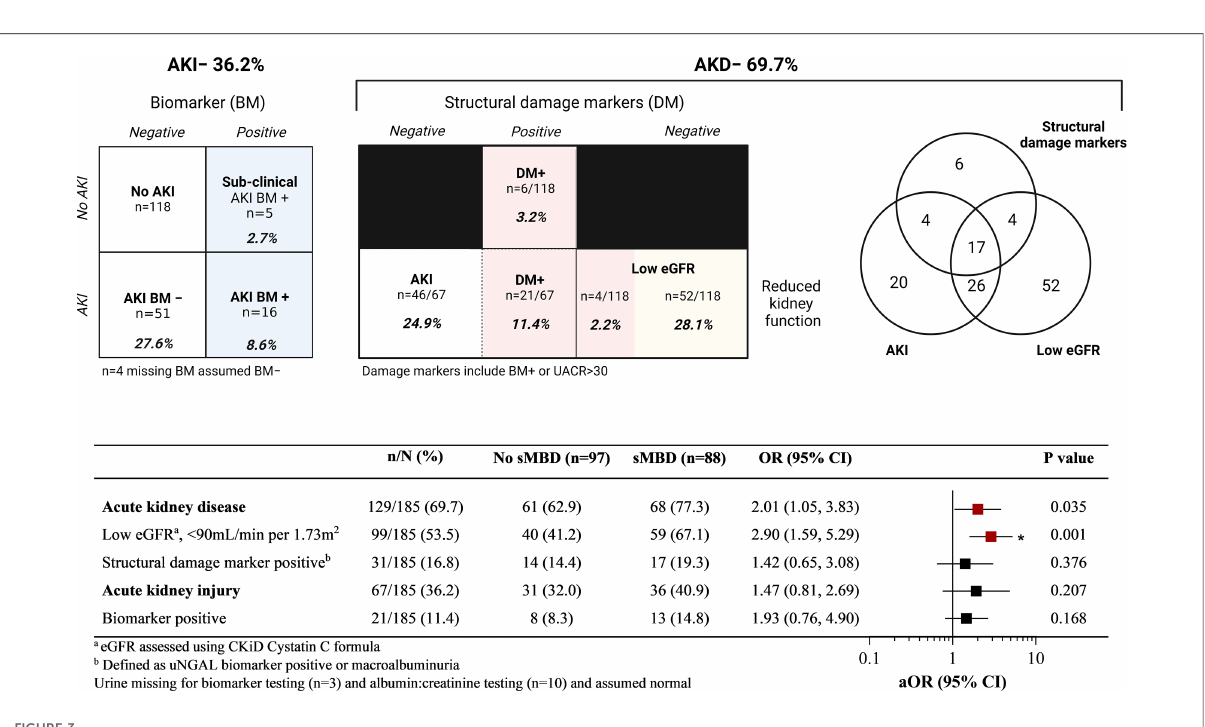
FIGURE 3 Relationship between acute kidney injury (AKI) and disease (AKD) and mineral bone disease in children with sickle cell anemia hospitalized for a vaso- occlusive crisis. Top. AKI de fi ned using acute changes in creatinine based on sKDIGO de fi nition. AKD was de fi ned based on presence of either a low GFR, AKI or presence of structural damage markers (DM). Structural damage markers included a positive biomarker test (BM+) (urine NGAL ≥ 150 ng/ ml), or urine albumin to creatinine ratio (UACR)>30 mg/mmol. The relationships between measures of kidney injury and disease are presented in the Venn diagram to the right. Bottom. A Forest plot depicting the frequency between different measures of kidney disease and the presence of sMBD. The adjusted odds ratio (aOR) is generated using logistic regression adjusting for participant age and sex. Relationships that were signi fi cant ( p < 0.05) are presented in red and those signi fi cant following adjustment for multiple testing are indicated with an asterisk. The adjusted p value to account for multiple testing was p <0.01 based on 5 comparisons. Created with BioRender.com.